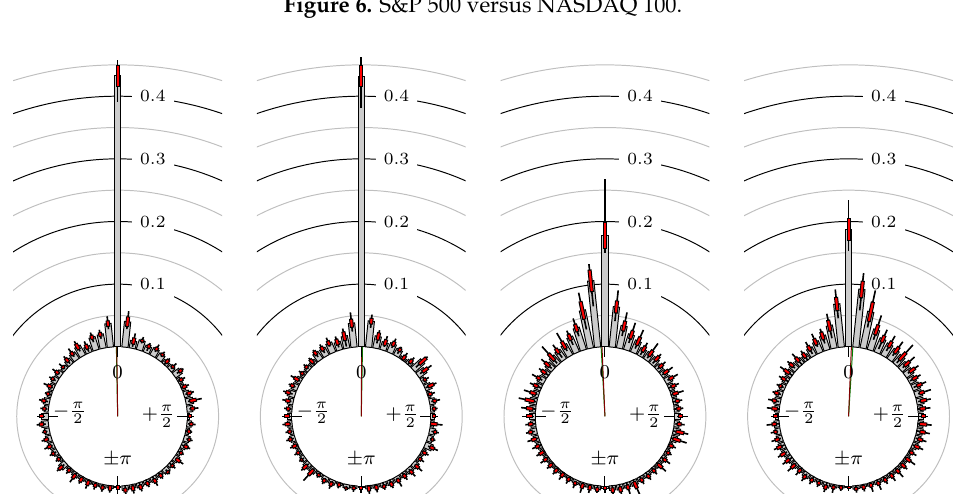
Figure 6. S&P 500 versus NASDAQ 100.